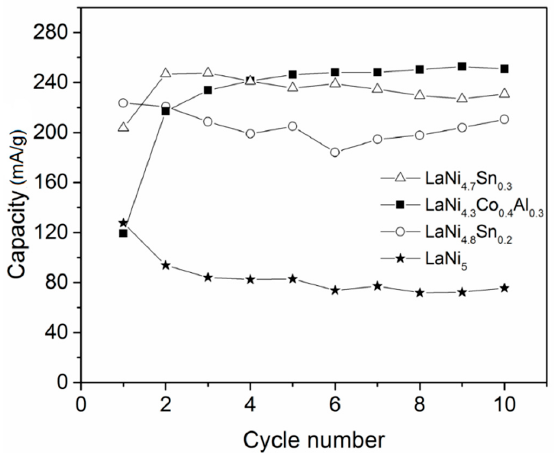
Figure 5. Discharge capacities vs. the cycle number for the alloys studied at a current density of 50 mA/g during the charge period and 20 mA/g during the discharge period.